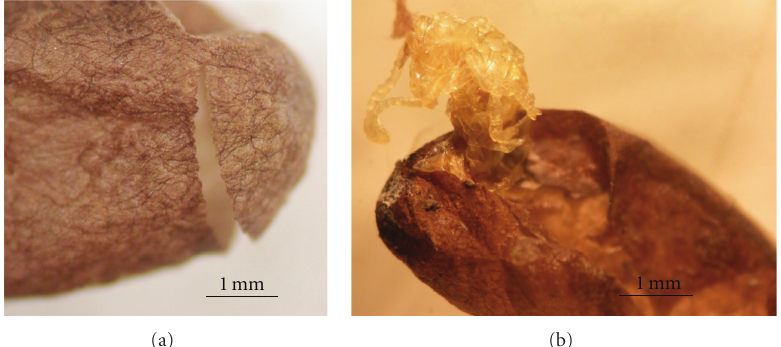
Figure 3: Operculum made by Kapala iridicolor wasp on emergence from the host cocoon. (a) View of the cocoon with operculum. (b) Host remains (only the ant cuticle is